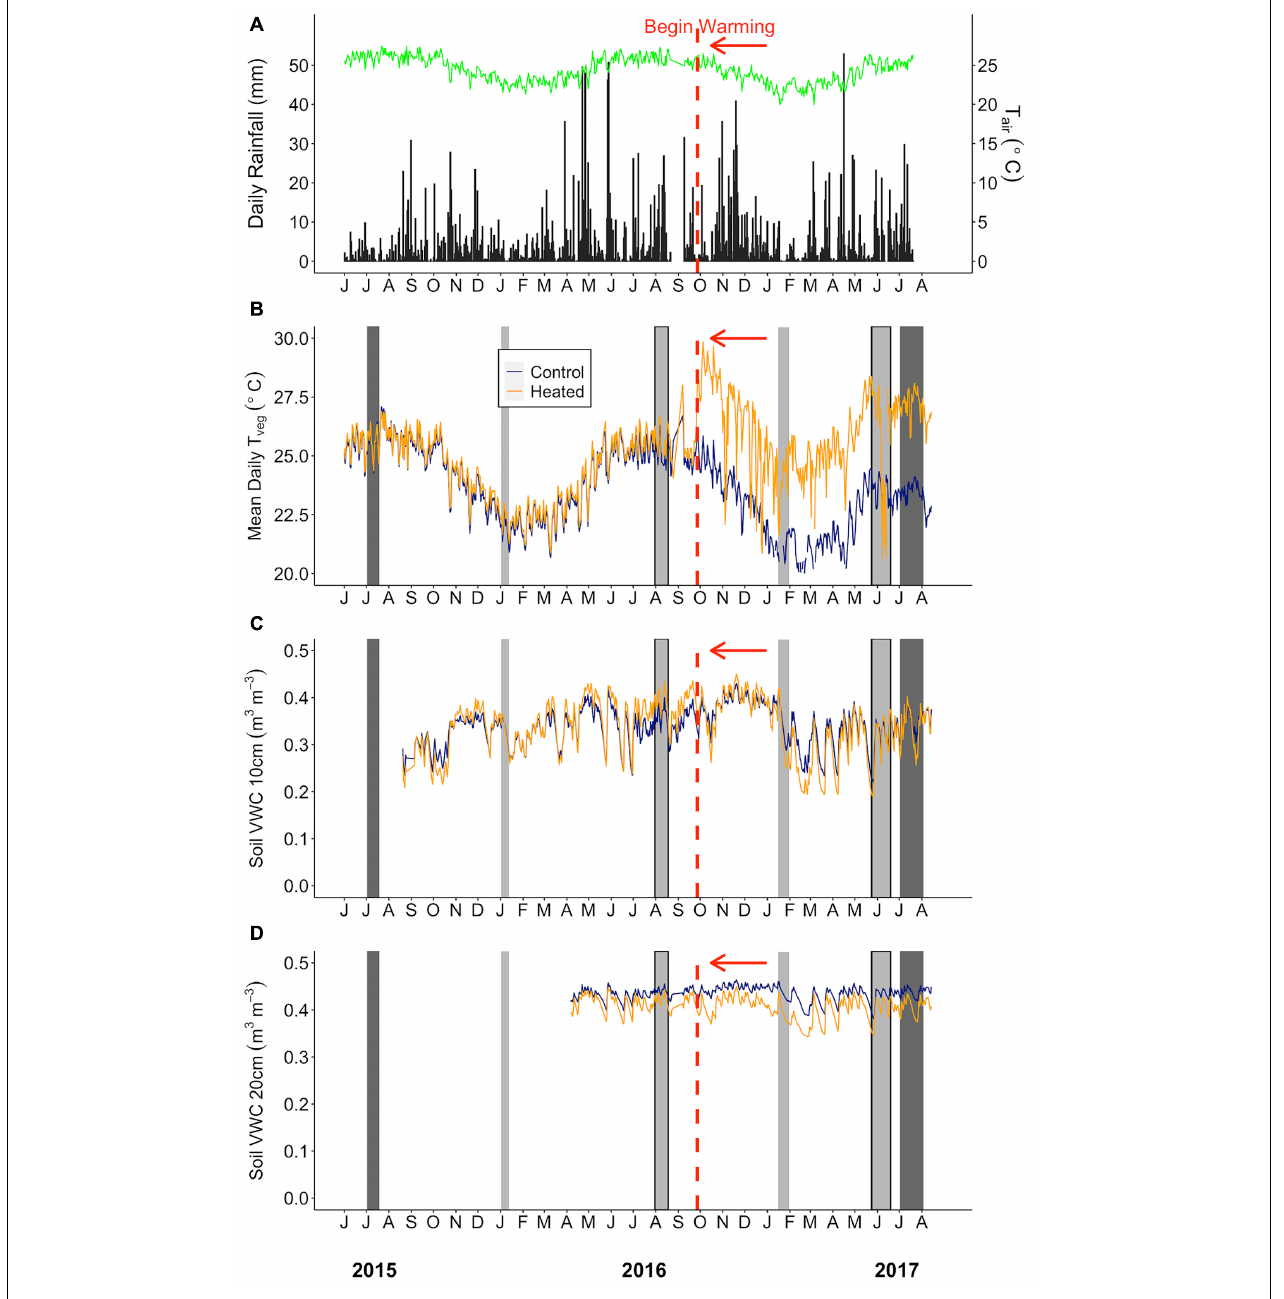
FIGURE 2 | Environmental summaries throughout the duration of the pre-warming and post-warming campaigns. (A) Daily rainfall (black bars) and average daily air temperature ( T air ; green line). (B) Mean daily surface vegetation temperature of the heated (orange) and control (dark blue) plots. Mean daily soil moisture at (C) 0–10 cm and (D) 20–30 cm depth for the heated and control plots. The dates shown range from July 1st 2015–August 15th 2017. The vertical red dashed line depicts the beginning of the warming treatment in the heated plots. The light gray bars depict A net and R dark sampling campaigns. The sampling campaigns that are light gray bars outlined in black (August 2016 and June 2017) depict campaigns where stomatal size and density was measured. The dark gray bars depict the V cmax and J max sampling campaigns. Rainfall and air temperature were collected from an above canopy weather station. Air temperature ( ◦ C) (HMP50-L, Campbell Scientific) was logged using a datalogger (CR1000, Campbell Scientific).